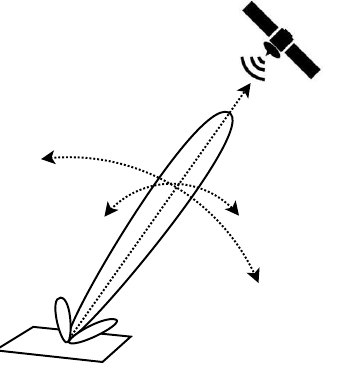
Figure 1. Example of a Collaborative Beamforming in a WSN placed over a surface to create a beam and reach a receiver placed on a